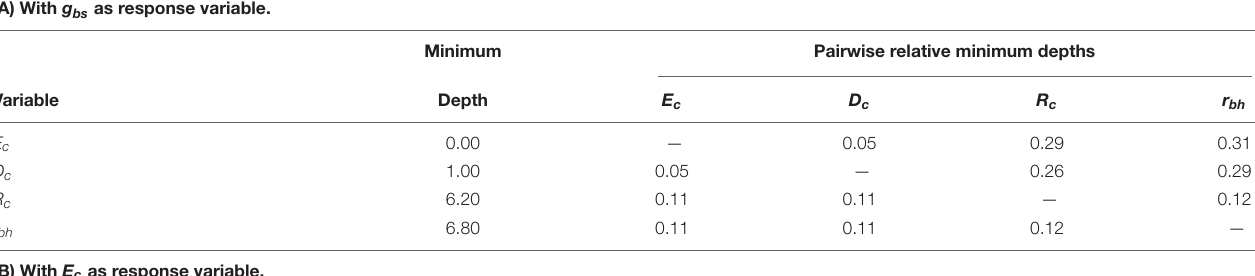
TABLE 1 | Predictor variable minimum depths and pairwise relative minimum depths between predictor variables for two regression models: (A) with g bs as the response variable; and (B) with E c as the response variable. (A) With g bs as response